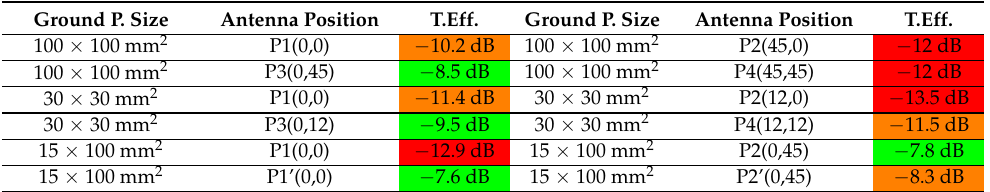
Table 3. Summary of the results. Red cell: Antenna in a wrong location, Orange cell: Antenna in an intermediate location, Green cell: Antenna in the optimum location Ground P. Size Antenna